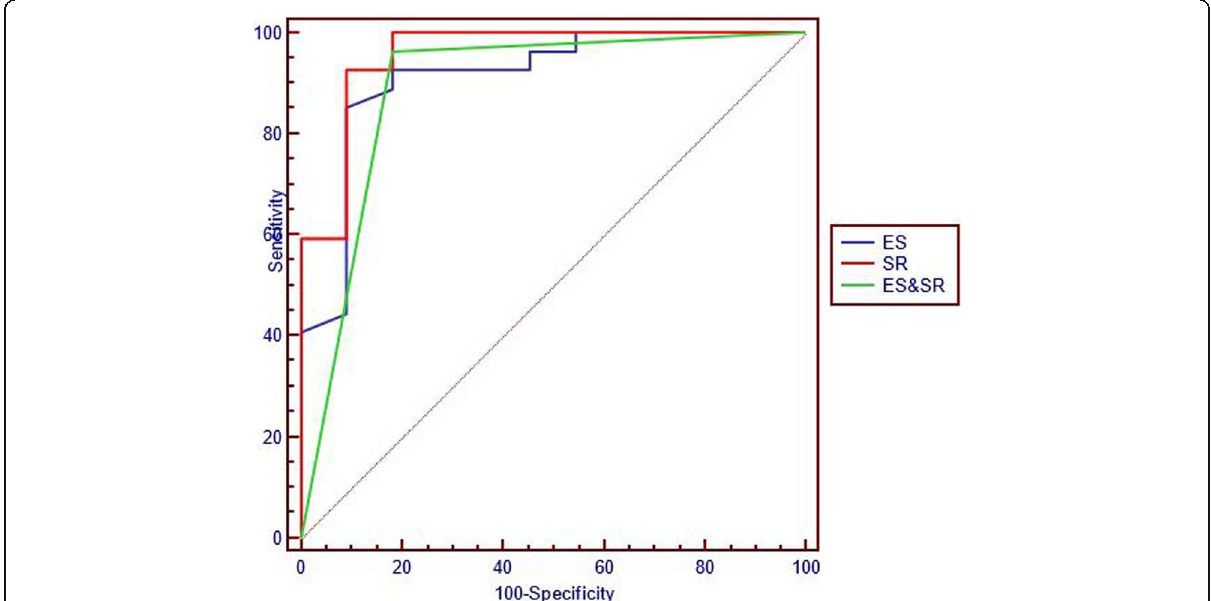
Fig. 1 ROC curve of ES and SR in isolation and combined for prediction of